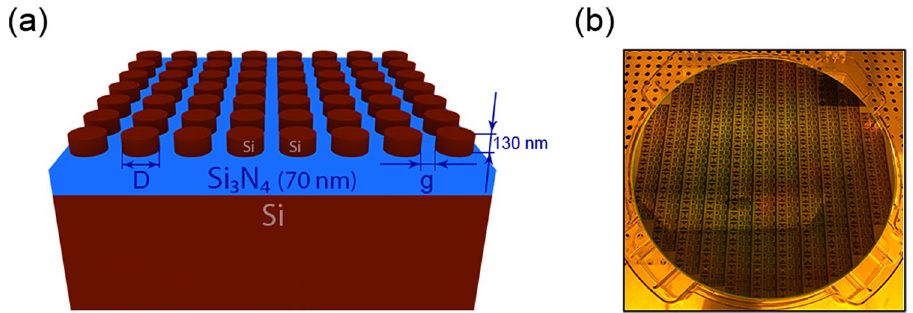
Figure 1. ( a ) Schematics of nanostructure design, ( b ) a photograph of the fabricated 12-inch wafer sample with photolithography mask.